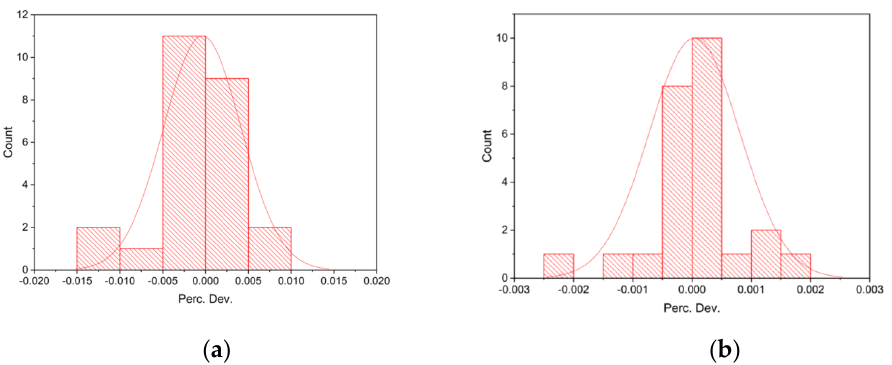
Figure 18. Histogram of the percentage deviation between experimental and predicted values for ( a ) compressive and ( b ) shear buckling.